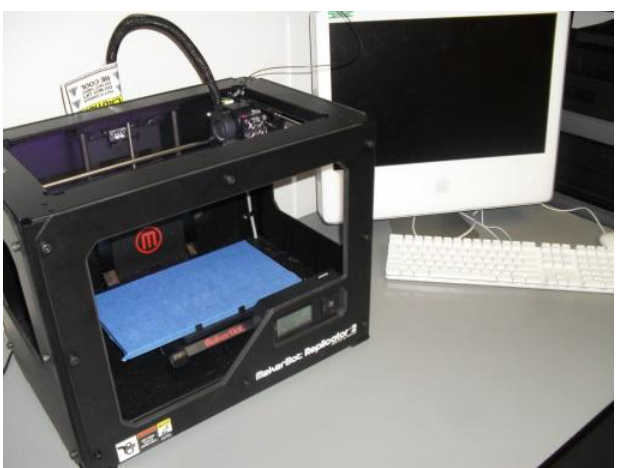
Figure 1. MakerBot 3D